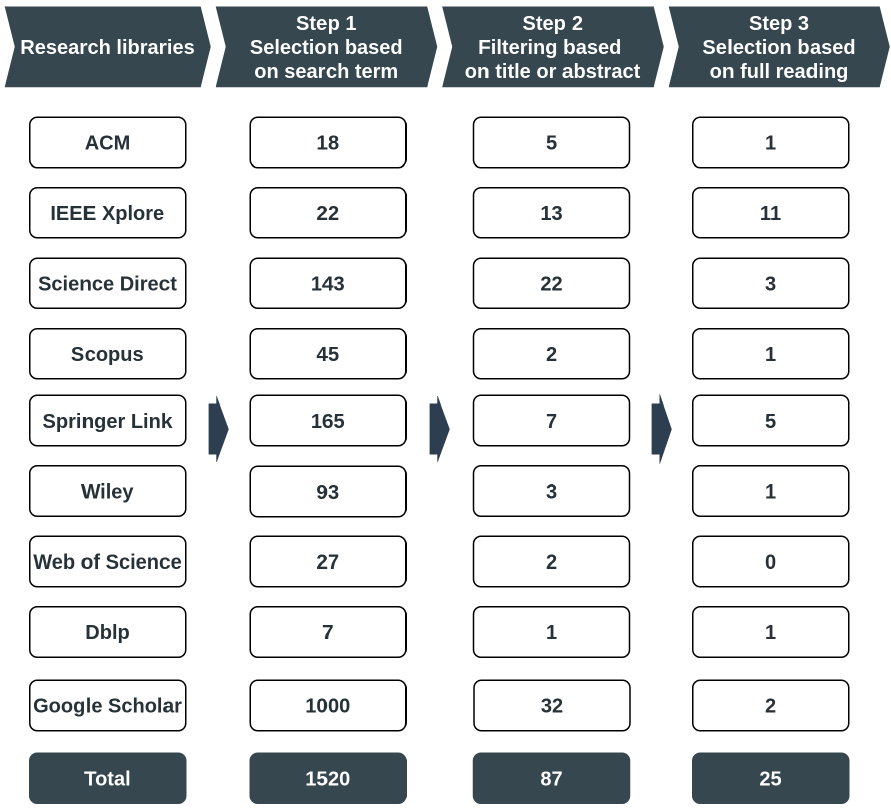
Figure 1. Flowchart for the selection of